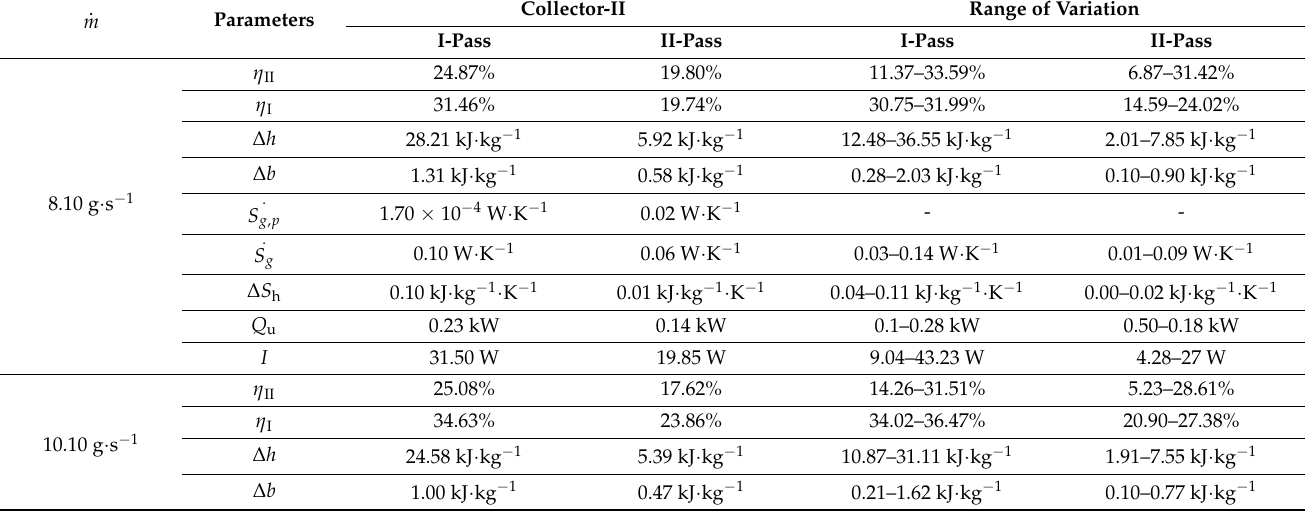
Table 6. Thermodynamic parameters of the air flowing across the parallel duct of